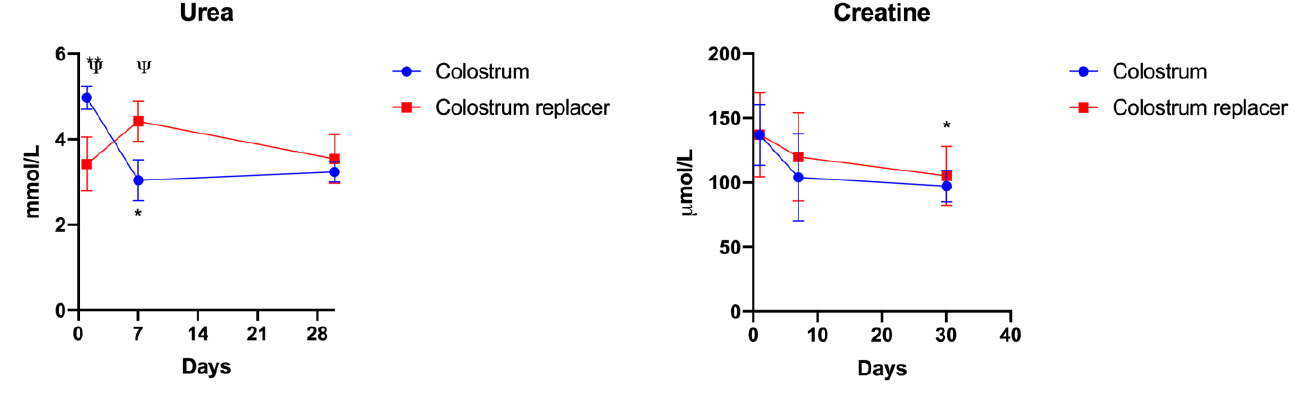
Figure 6. The changes in serum urea and creatinine concentration in calves that received a colostrum or colostrum replacer diet for the first 6 hours postpartum. The experimental animals ( n = 5 in each group) received colostrum or an artificial colostrum replacer for the first 6 h after birth. On days 1, 7 and 30, the venous blood was collected and analyzed. The results are shown as mean ± SEM from five experimental animals. Ψ – p < 0.05 indicates significance between experimental groups. * p < 0.05, ** p < 0.01 indicates significant changes between time points of the same group.